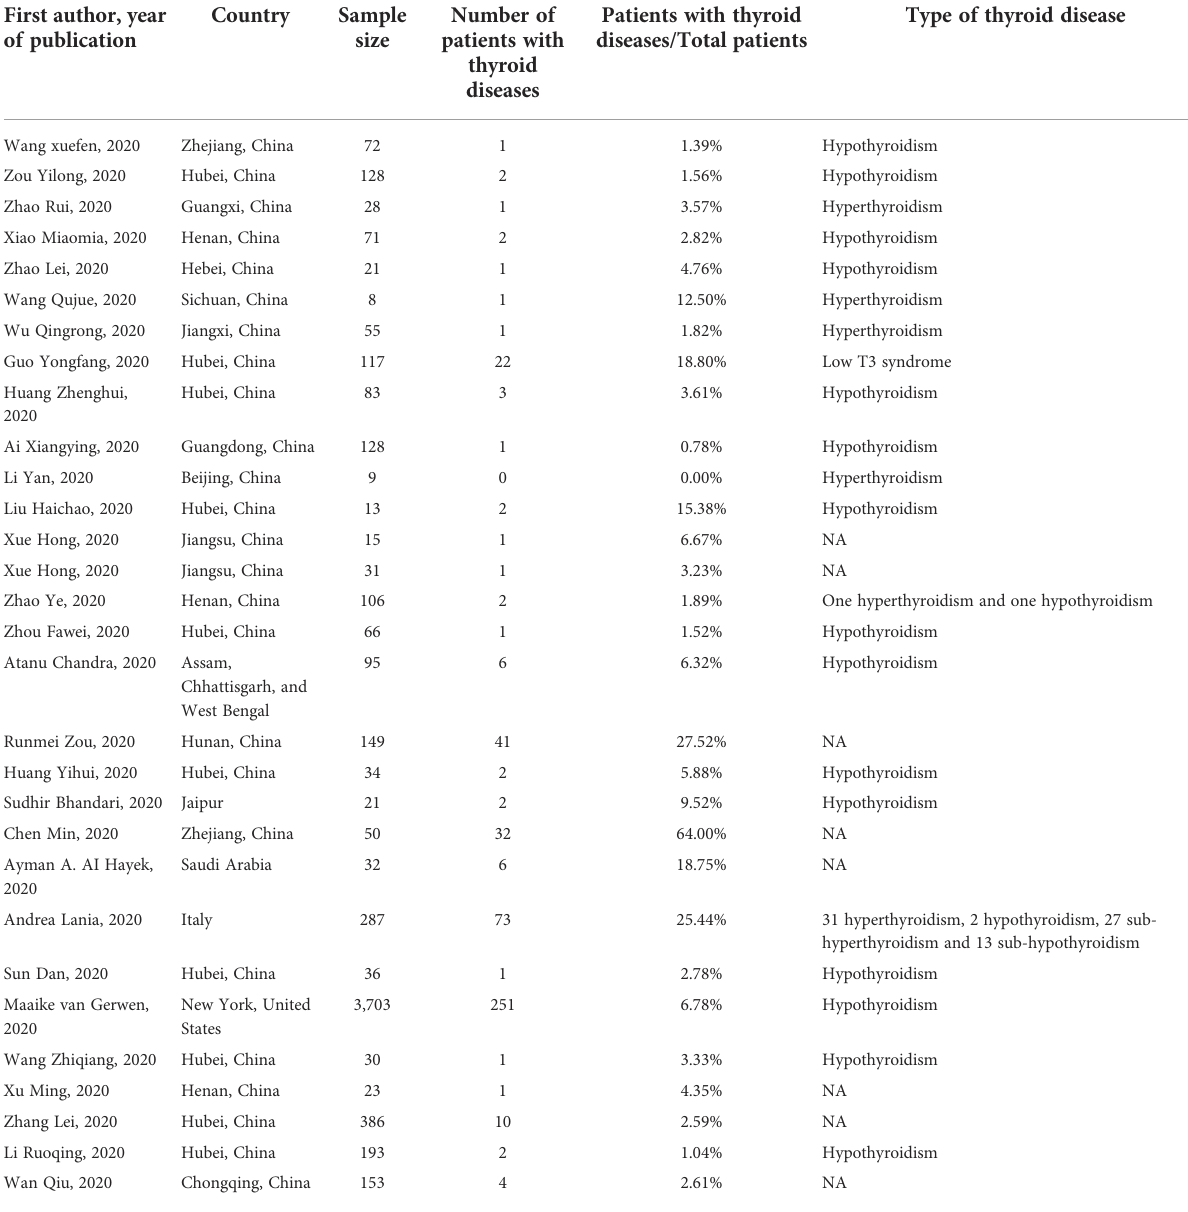
TABLE 1 Characteristics of the 53 included